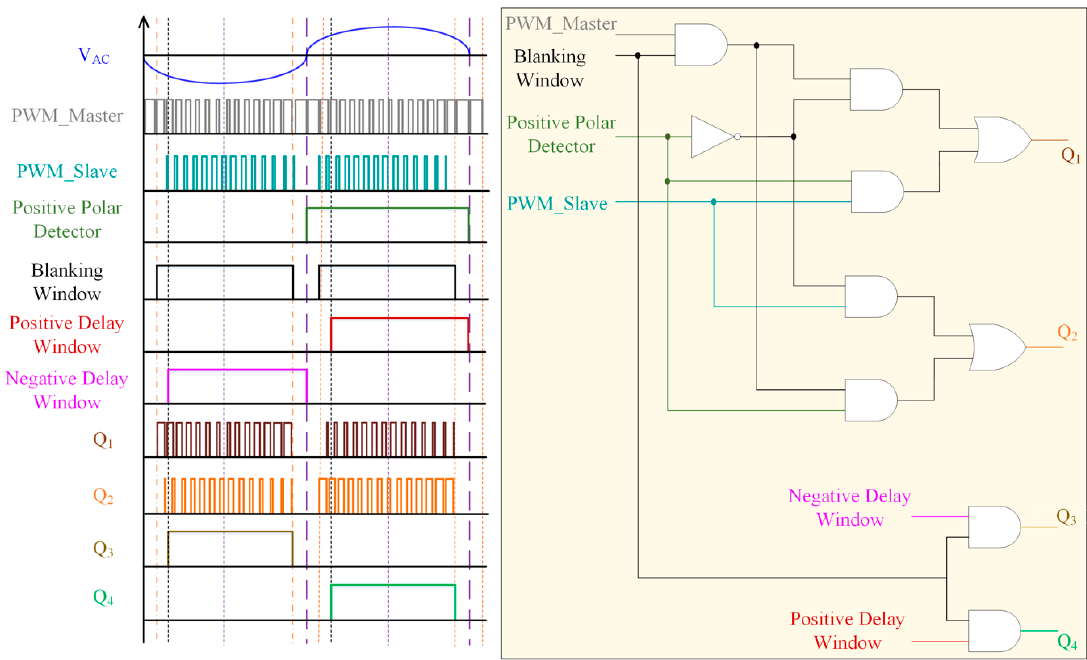
Figure 6. Key signal sequence ( left ) and auxiliary logic circuit ( right ) of the proposed control structure.